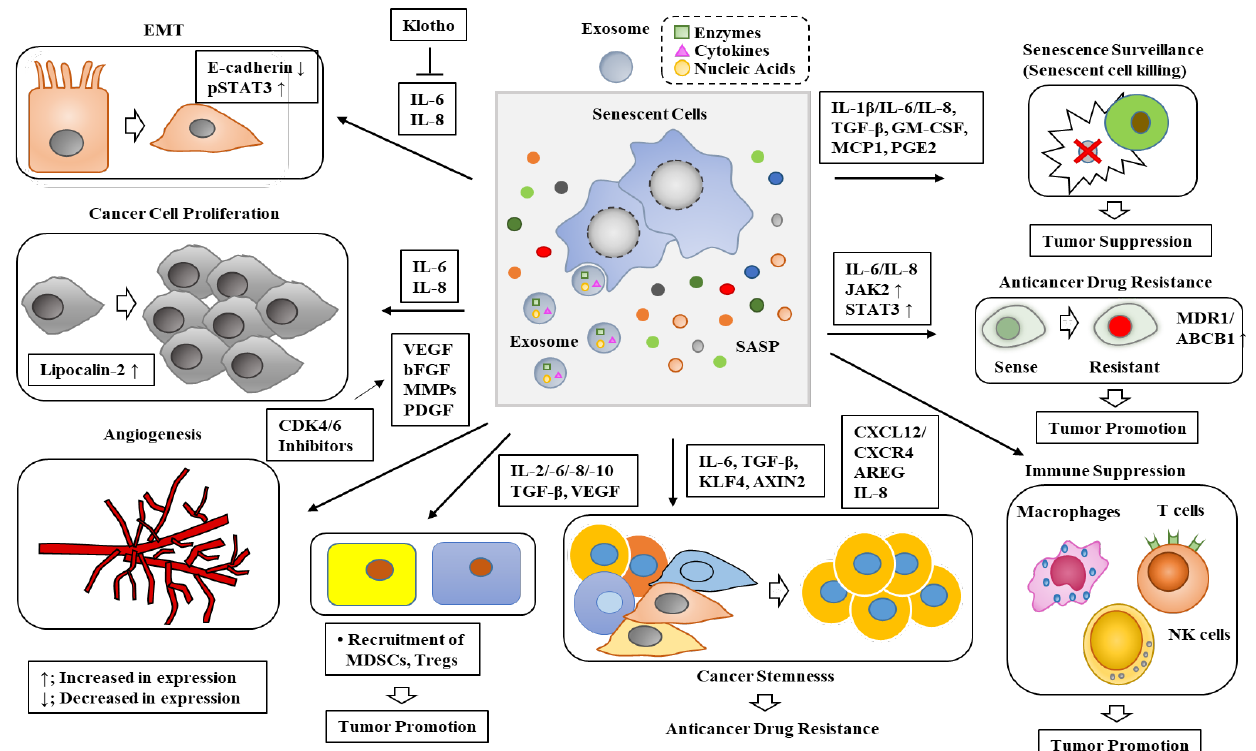
Figure 4. Roles of the SASP in tumor promotion and tumor suppression. The SASP of senescent cells regulates various life processes in a paracrine fashion. The SASP eliminates senescent cancer cells (senescence surveillance). The SASP exerts immune suppression to promote tumor progression. The SASP contains various cytokines/chemokines, MMPs, and soluble extracellular vesicles (EVs) to promote these activities. The hollow arrows and black arrows indicate the direction of reaction. → indicates the direction of the reaction. ↑ indicates an increase in expression/activity. ↓ indicates a decrease in expression/activity. The T bar indicates a negative regulation.